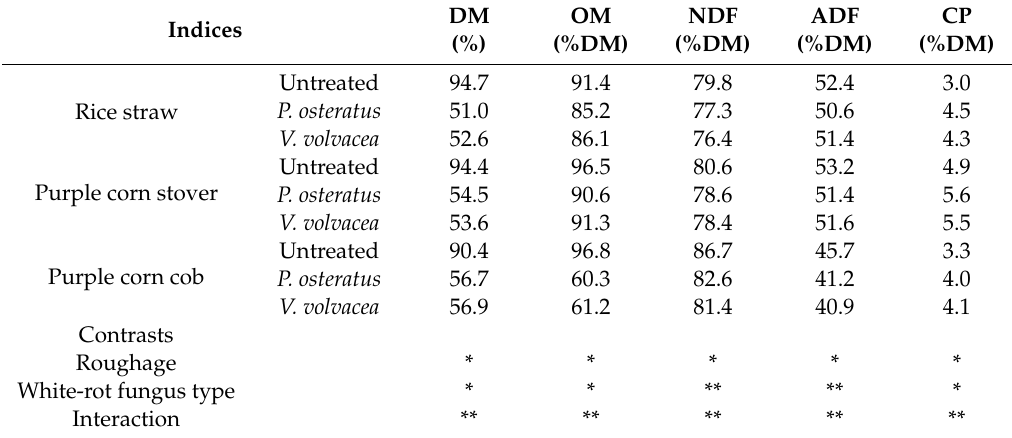
Table 1. Chemical composition in rice straw, purple field corn stover, and